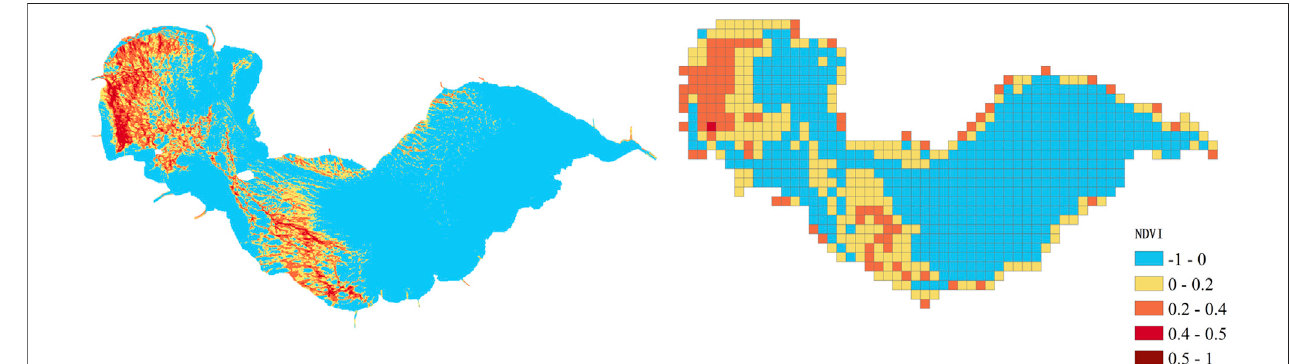
FIGURE 2 | NDVI distribution with grid cell division from 2014.08.15.